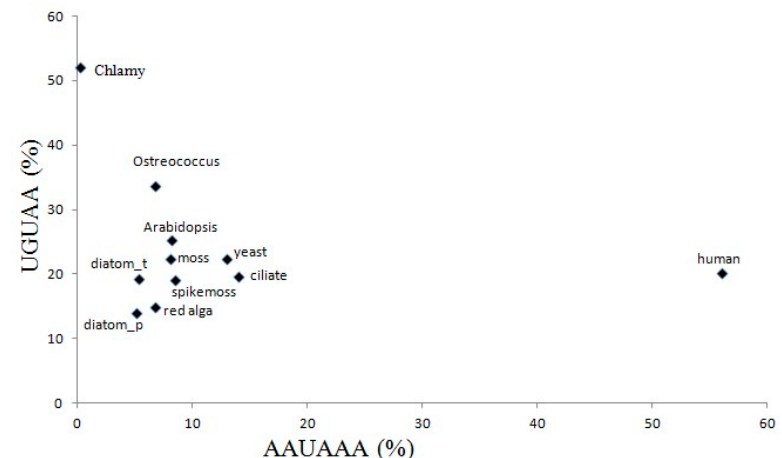
Figure 4. The overall frequencies of UGUAA and AAUAAA in a 2-D coordinate in the 11 species. Abbreviations: chlamy, green alga C. reinhardtii ; Ostreococcus, green alga O. lucimarinus ; diatom_t, diatom T. peudonana ; diatom_p, diatom P. tricornutum .